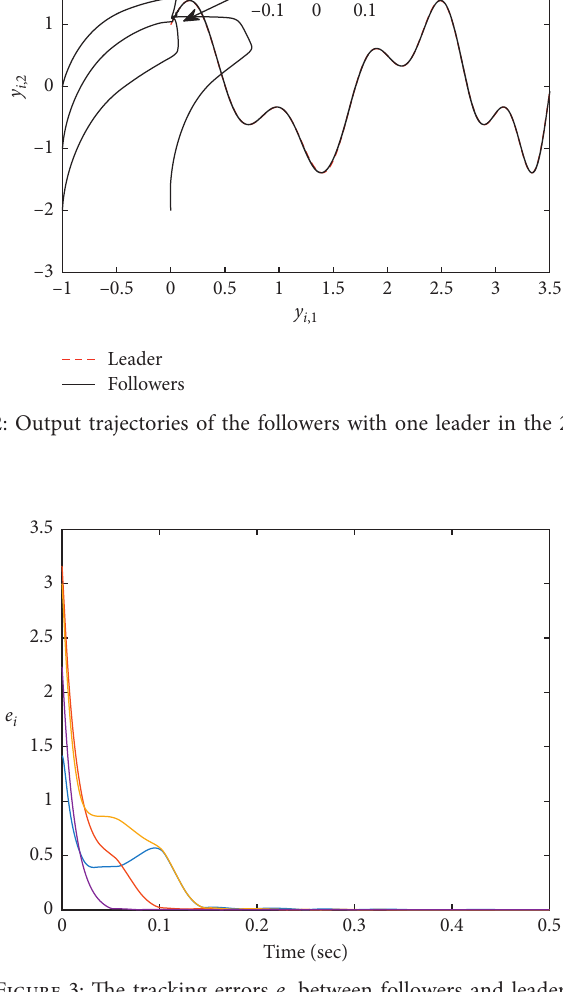
i between followers and